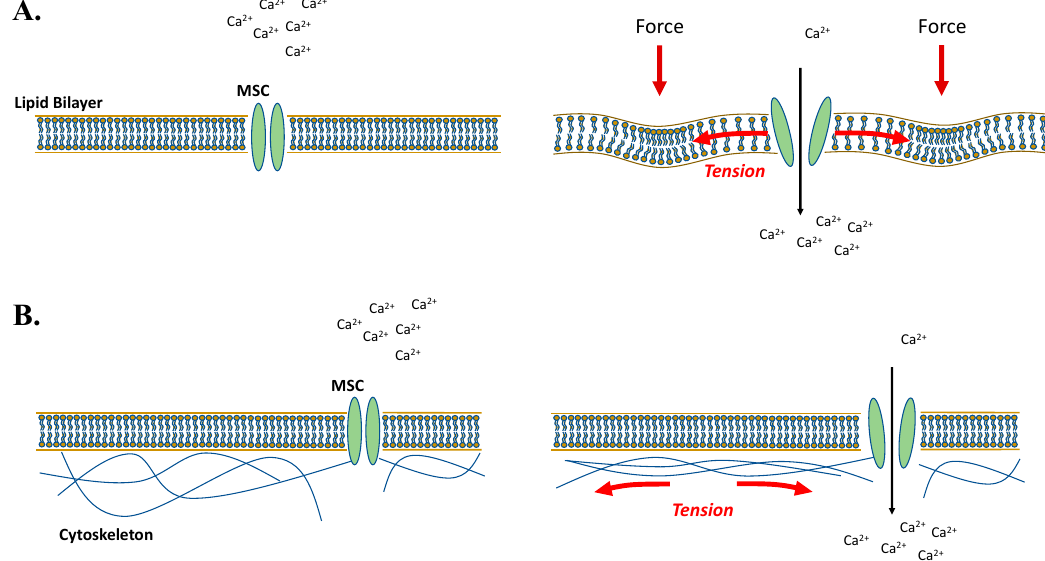
Figure 1. Models for activation of mechanically sensitive ion channels. Two prevailing mechanisms for the transmission of forces to mechanosensitive ion channels (MSC) for gating are ( A ) tension in the lipid membrane and ( B ) tension in the cytoskeleton. A: Force transmission from exogenous mechanical stimuli create tension in the cell membrane that is transmitted to ion channels resulting in channel gating and ion flux. The bacterial MscL, MscS, MscM channels and mammalian Piezo channels are gated directly by membrane tension. B: Alternatively, for ion channels directly linked to the cytoskeleton, gating and ion flux can result from the transmission of tension in the cytoskeleton to MSCs, such as the drosophila TRP channel NOMPC.